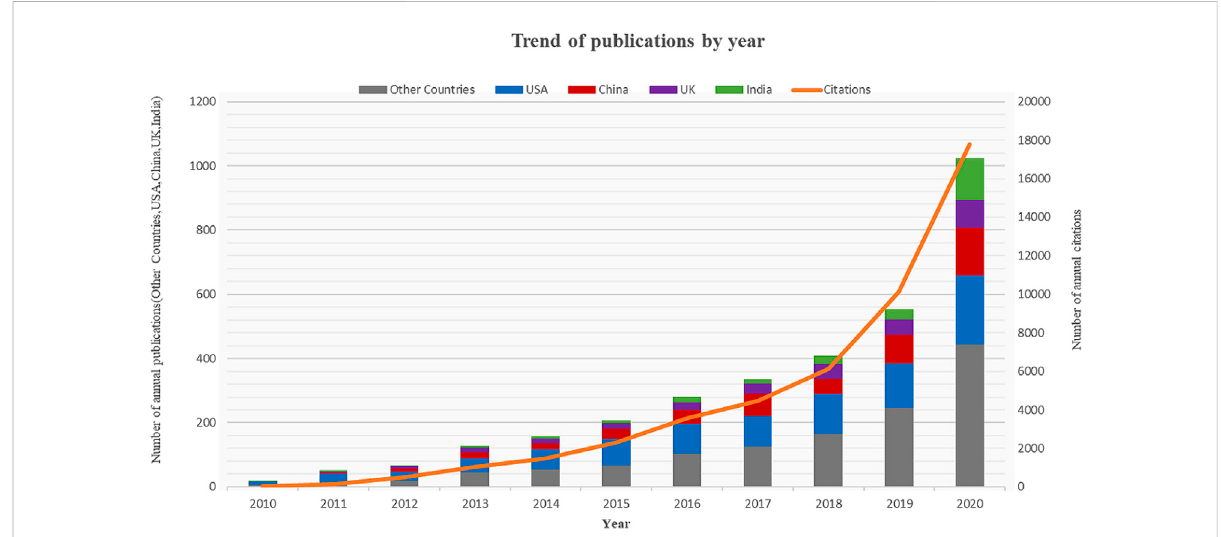
FIGURE 2 Annual trends in the number of articles published and citations related to drug repositioning.